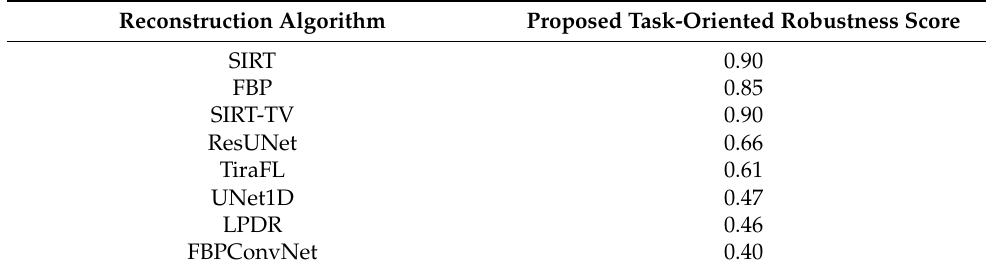
Figure 8. Images with distorted reconstructions M ( P + ∆ P ) from Equation (15). The title of each image corresponds to the reconstruction method. Table 2. Averaged over 30 reconstructed images, the proposed task-oriented robustness score of the reconstruction algorithms calculated for the reconstruction perturbation A applied to the reconstructed image is shown in Figure 5.